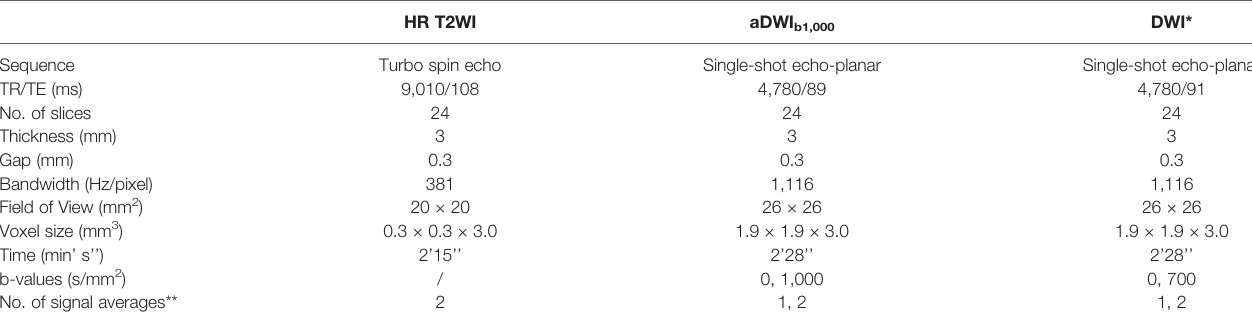
TABLE 1 | Imaging Protocol Parameters for DWI and HRT2WI Sequences.